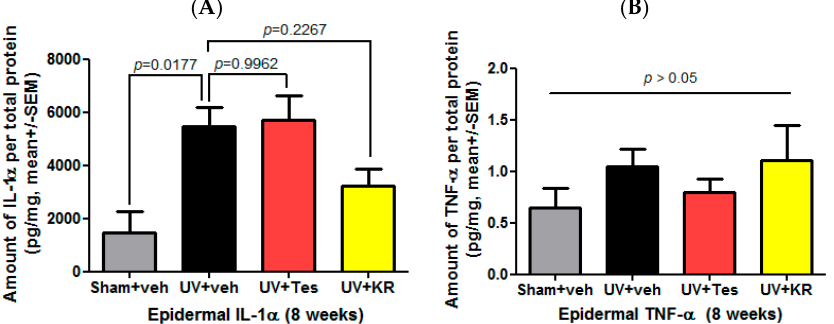
Figure 9. Effect of a mixture of extracts of Kochia scoparia and Rosa multiflora (KR) on cytokine expression in the epidermis of photoaging murine skin. Epidermal expression of IL-1 α and tumor necrosis factor (TNF)- α , represented by the expression of proinflammatory cytokines, was determined by a cytokine assay using a Milliplex kit after topical application of KR, vehicle (veh), or tesaglitazar (Tes) for 8 weeks. In photoaging skin, epidermal IL-1 α ( A ) and TNF- α ( B ) increased. KR decreased epidermal IL-1 α ( A ), but not epidermal TNF- α ( B ).